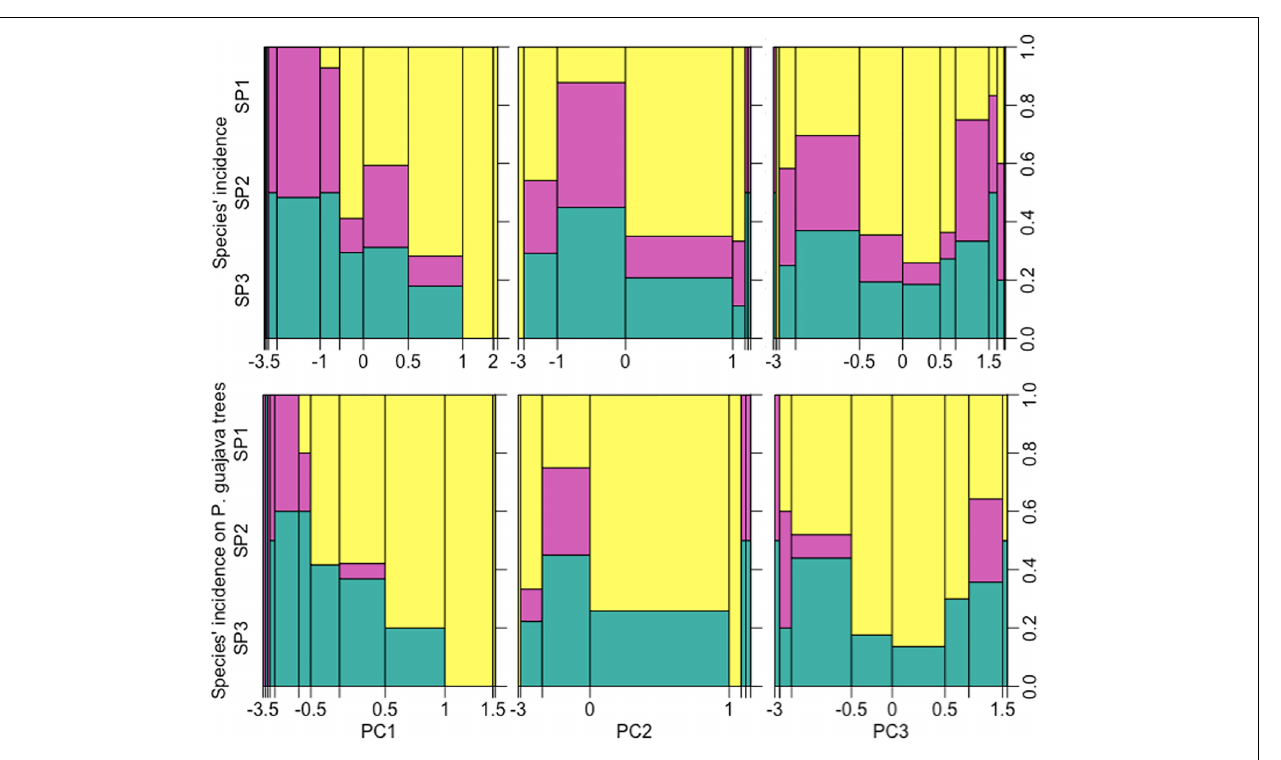
FIGURE 8 | Changes in the relative frequency of A . sp.1 (yellow), A . sp.2 (purple), and A. sp.3 (green) across equally distributed segments of principal components representing climate and geography. Wider segments indicate that more records were made across the respective PC ranks. The length of each colored column represents the proportion of each species in records for a given segment in conditions. PC1 represents increases in precipitation seasonality and distance from the coast and increasing proximity to equator. PC2 depicts increases in the diurnal and annual temperature range. PC3 represents decrease in annual precipitation and increasing